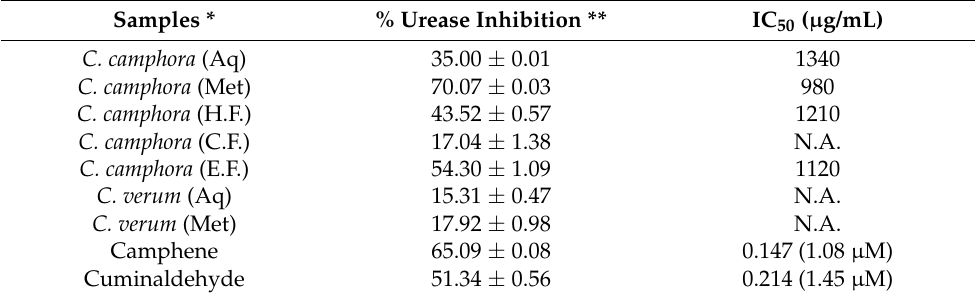
Inhibition studies of the plant extracts/sub fractions/pure compounds against urease enzyme. Samples * % Urease Inhibition ** IC 50 ( µ